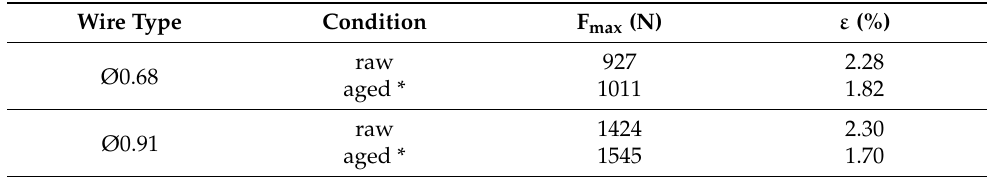
Table 7. Mean maximum force and total strain values of Ø0.68 and Ø0.91 wires in untreated and aged